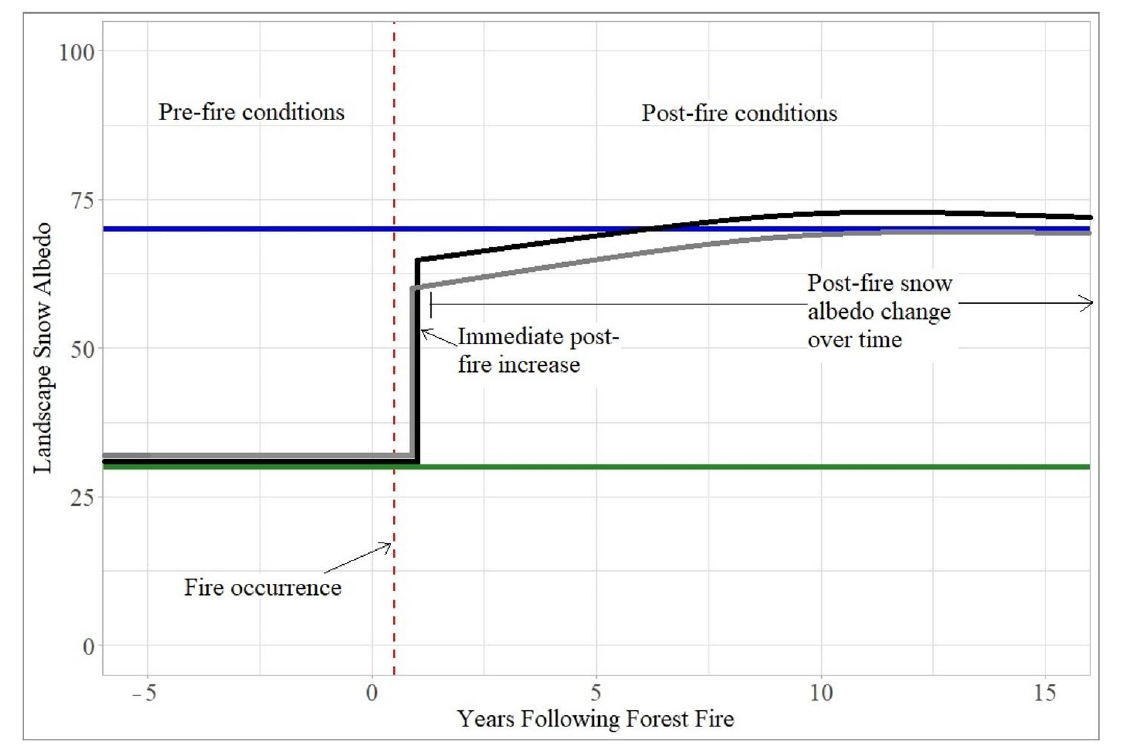
Figure 1. Conceptual model of pre- and post-fire landscape snow albedo relative to burn severity. Conceptual results of forest fire effects on snow albedo for each burn severity classification, including pre-fire conditions, immediate post-fire increase, and overall post-fire snow albedo change over time (recovery).